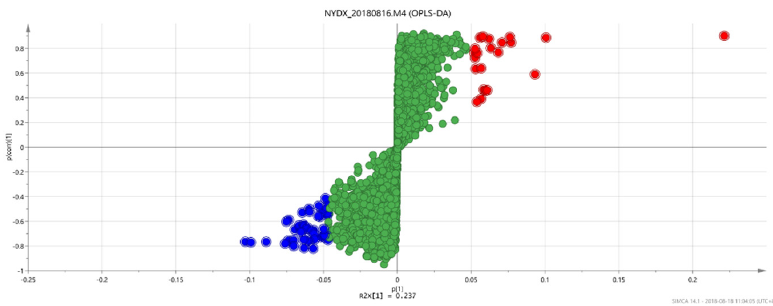
Figure 10. OPLS-DAS-plot diagram between group 2 and group 3.